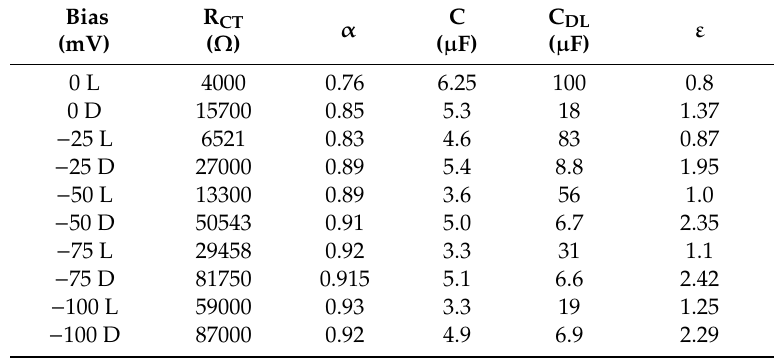
Table 2. EEC parameters for Dataset 2. Nominal impedance solution is less than 60 Ω